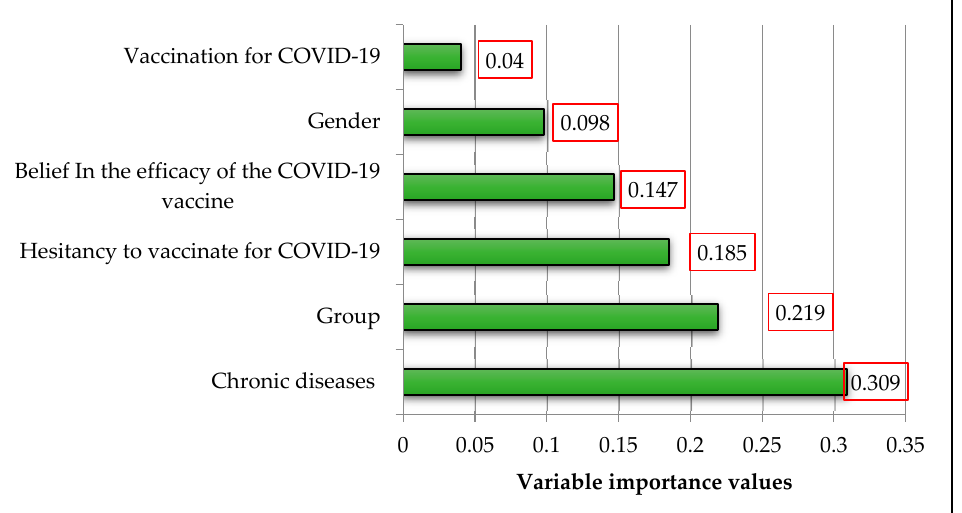
Figure 1. The graph of the variable importance values for DASS-21 total score . Table 9. Variable importance values obtained from the MLP model for CAS-SF .